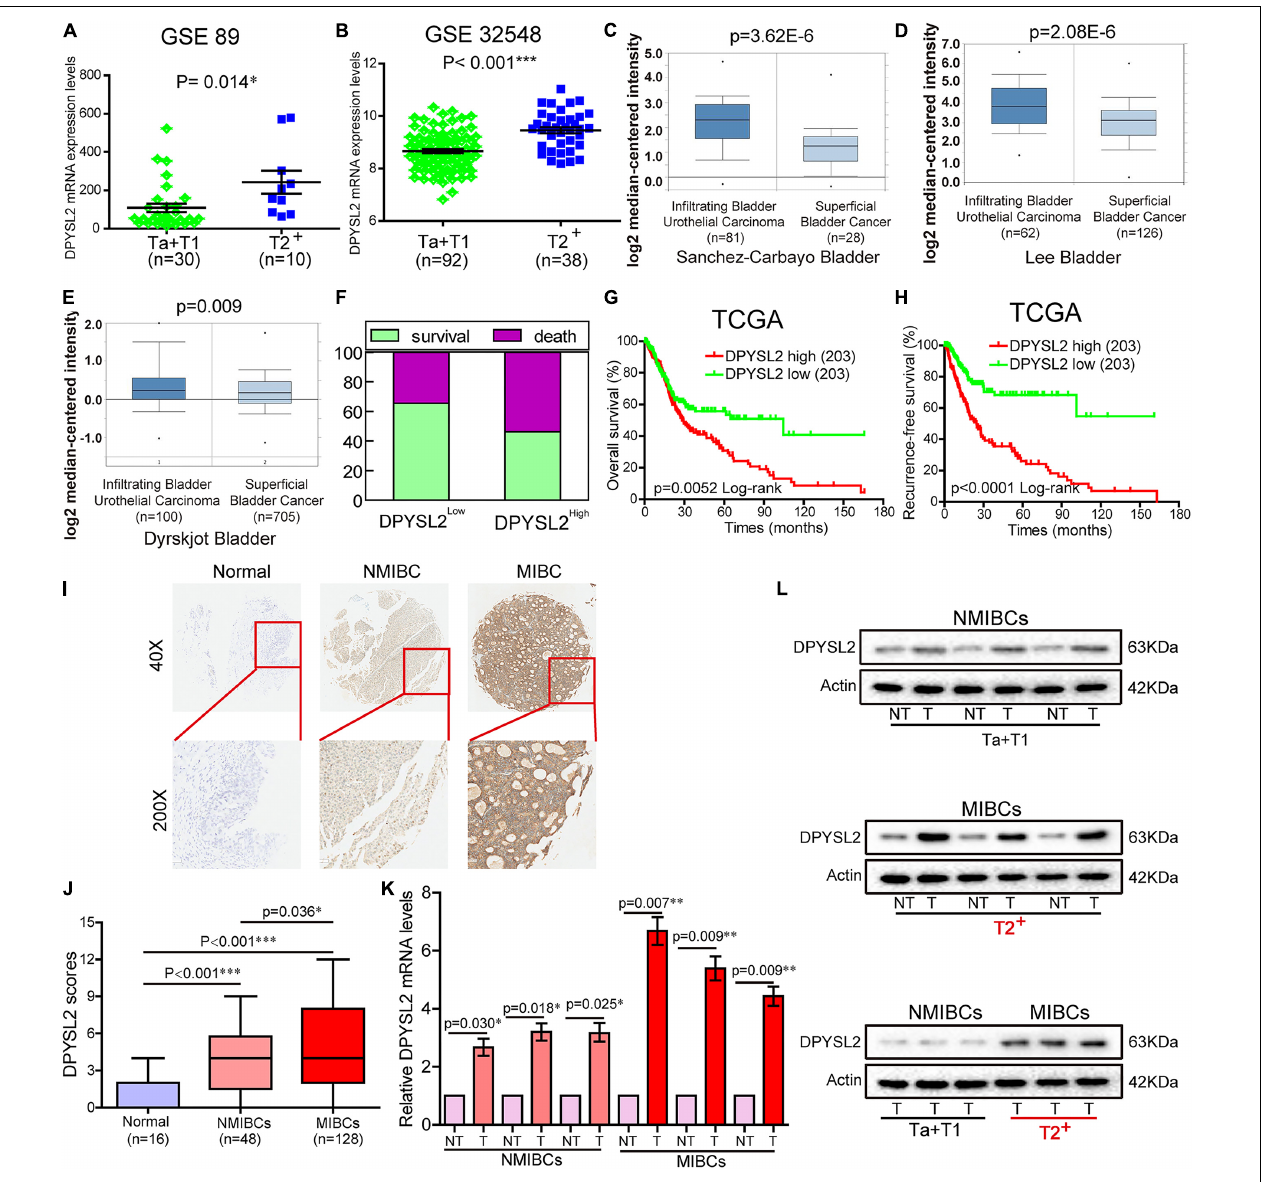
FIGURE 1 | Dihydropyrimidinase like 2 (DPYSL2) upregulation correlated with tumor staging and poor survival in patients with bladder cancer. (A,B) In the GSE89 and GSE32548 datasets, DPYSL2 mRNA levels were significantly higher in muscular invasive bladder cancer (MIBC) samples ( ≥ T2) than those in non-muscular invasive bladder cancer (NMIBC) samples (Ta and T1). (C–E) DPYSL2 mRNA levels were significantly increased in infiltrating bladder urothelial carcinoma compared with those in superficial bladder cancer in the Oncomine database. (F–H) In a TCGA bladder cancer specimen cohort ( n = 406), the patients with high DPYSL2 expression had increased death rates (F) and decreased overall survival (G) and recurrence-free survival (H) , compared with the patients with low DPYSL2 expression. (I,J) Immunohistochemical staining was performed to detect the protein levels of DPYSL2 in a bladder cancer tissue microarray containing non-cancerous ( n = 16), NMIBC ( n = 48), and MIBC ( n = 128) tissue samples. Representative images are shown. Magnification 40 × , 200 × . (K,L) Quantitative real-time PCR (qRT-PCR) and Western blot analysis were conducted to measure mRNA and protein levels of DPYSL2 in randomly selected paired fresh-frozen bladder cancer and adjacent non-cancerous bladder tissue samples. Actin was used as an internal reference. Data are expressed as the mean ± standard error of the mean (SEM). * P < 0.05, ** P < 0.01, *** P < 0.001; n = 6. T, tumor; TCGA, The Cancer Genome Atlas; DPYSL2, dihydropyrimidinase like 2; NMIBC, non-muscular invasive bladder cancer; MIBC, muscular invasive bladder cancer; NT, non-cancerous tissue.